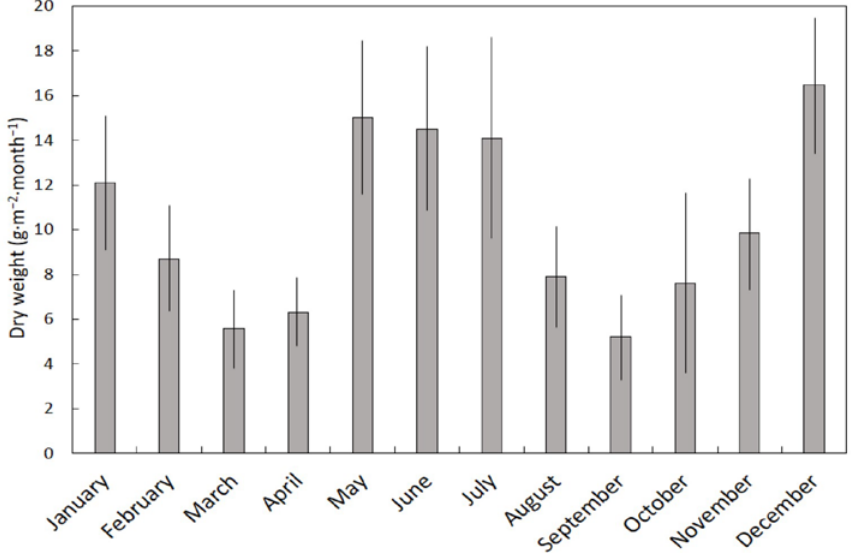
Figure 1. The influence of month on leaf litterfall beneath a Serianthes nelsonii tree. Mean ± SE, n = 6. The macronutrients contained within the monthly leaf litter pools were highly con- trasting among the elements and months (Table 1). The leaf litter inputs of C paralleled those of litter mass, as almost half of the leaf litter comprised C. The monthly mean was 4631 mg·m −2 , and there was a 3.1-fold range in C among the months. The VI for N and P were similar to that of C, but the differences between the months were not significant. Leaf N averaged 174 mg · m − 2 , and leaf P averaged 10 mg · m − 2 . Leaf K was the most variable macronutrient, with a minimum in April and a maximum in December. Leaf Ca was the most abundant element in the litter after C, and the monthly mean was 310 mg · m − 2 . Leaf Mg pattern was unique, with a minimum in September and a maximum in May. Table 1. The influence of month of year on macronutrient return (mg · m − 2 ) in Serianthes nelsonii leaf litter.